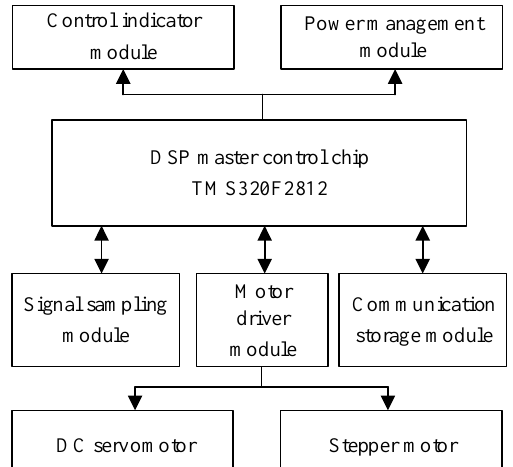
Figure 7. The overall structure of the control and detection circuit in the microdestructive tree-ring measurement system.